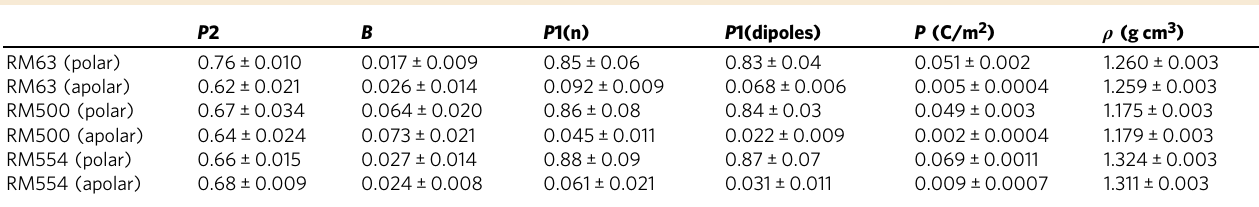
Second-rank orientational order parameter ( P 2), biaxial order parameter ( Β ), polar order parameter ( P 1), order parameter of the polarization vector ( P 1(dipoles)), polarization vector ( P ) at 400K for polar or apolar molecular dynamics simulations of homologous of RM734; all values are an average over each timestep in the production MD run (30 – 280ns) as described in the text, with plus/minus values corresponding to one standard deviation from the